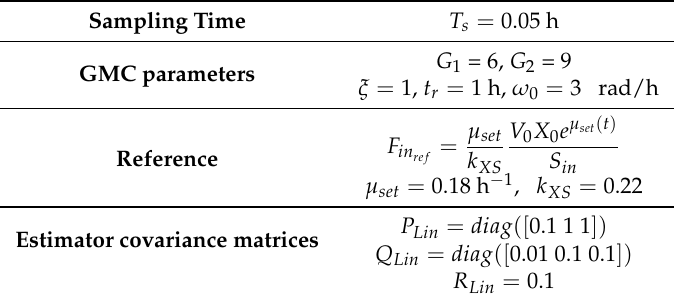
Table 9. Control and estimation parameters used in the experiments.